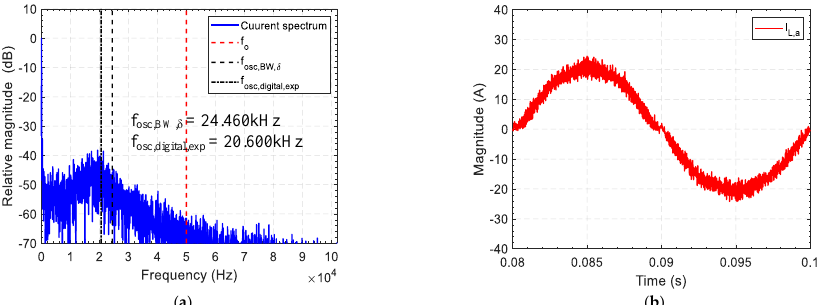
Figure 22. Simulation results under DPSSOCC control with experimental parameters and white noise: ( a ) current spectrum and ( b ) input current